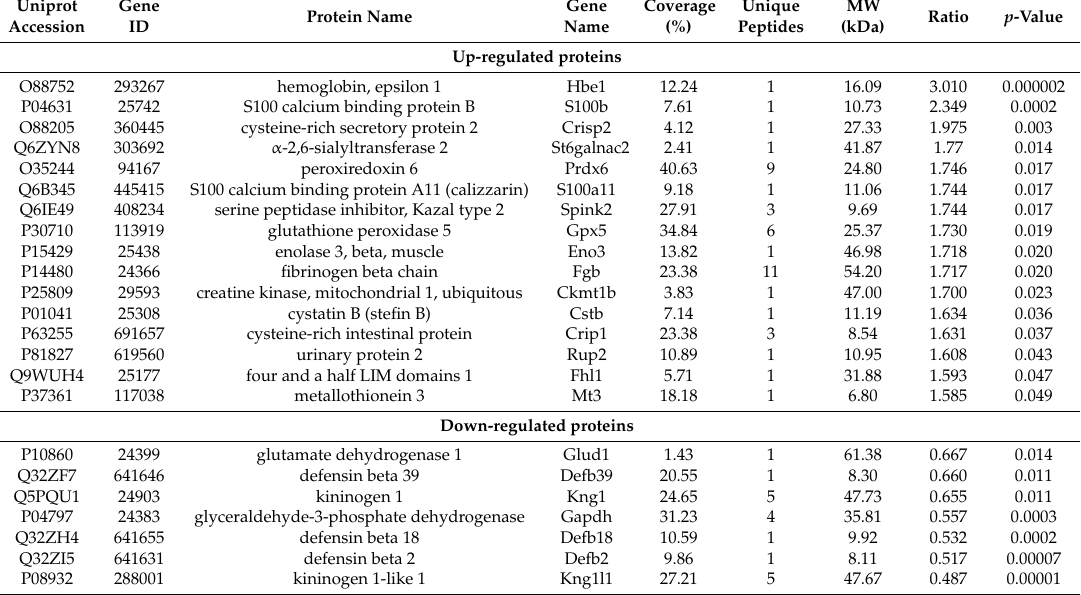
Table 4. iTRAQ analysis of differentially expressed proteins in the epididymal luminal fluids between the dutasteride group and control